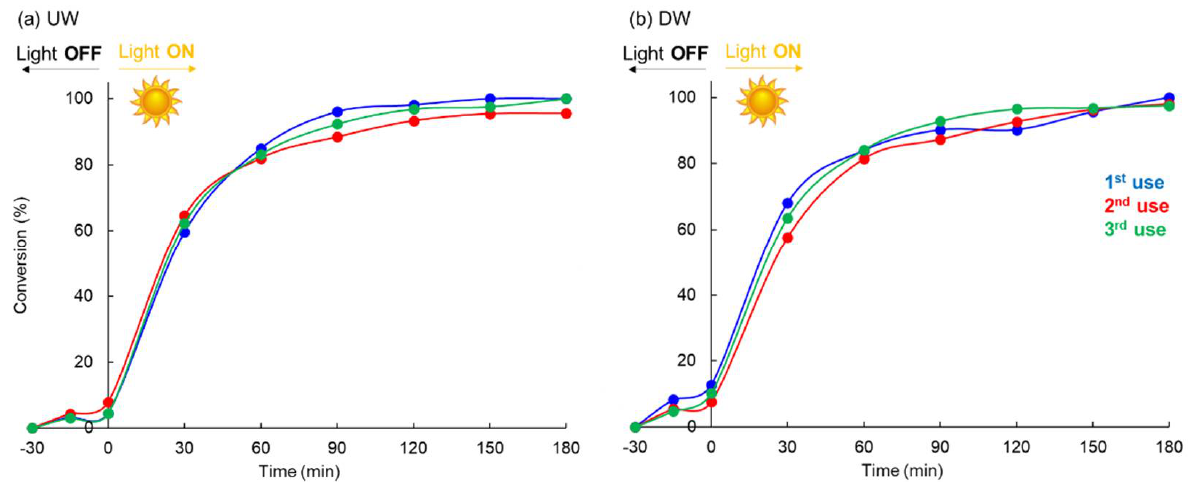
Figure 11. Reusability tests of STOm (1.00 g · L − 1 ) towards DCF photodegradation in UW ( a ) and DW ( b ).